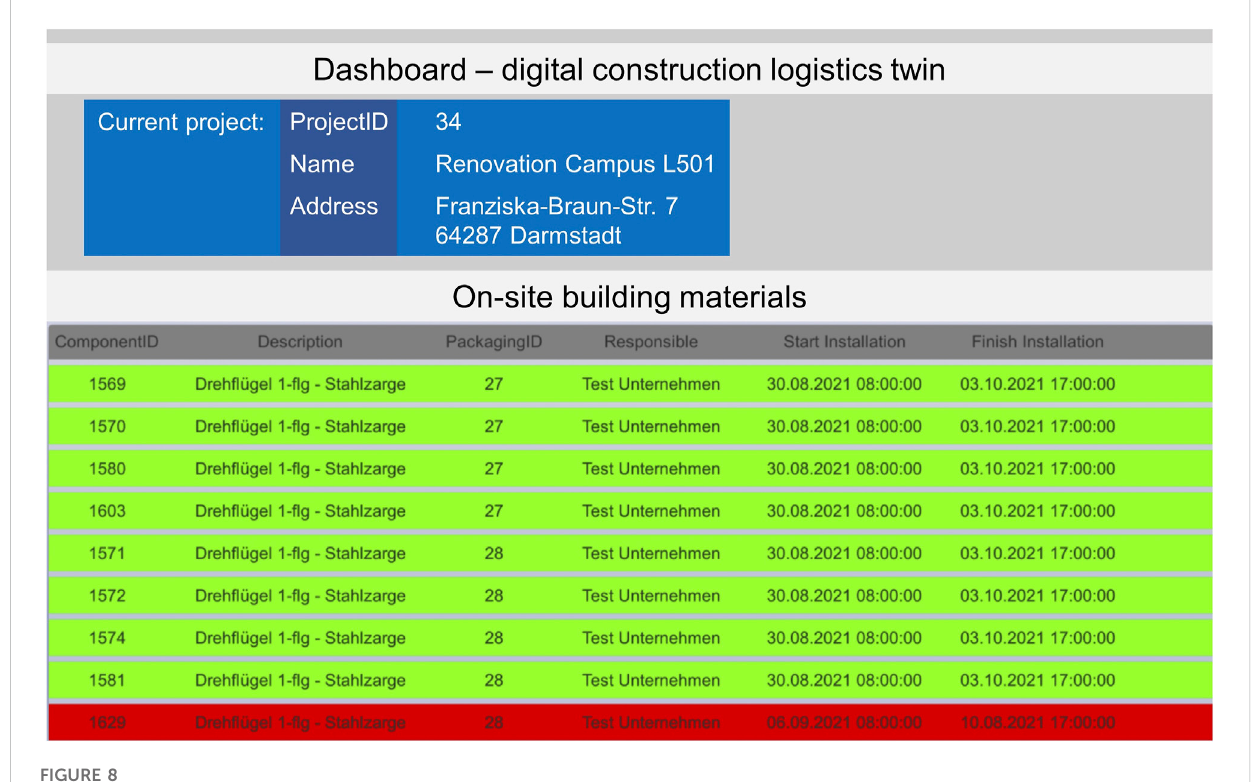
FIGURE 8 Controlling dashboard for the exemplary mobile